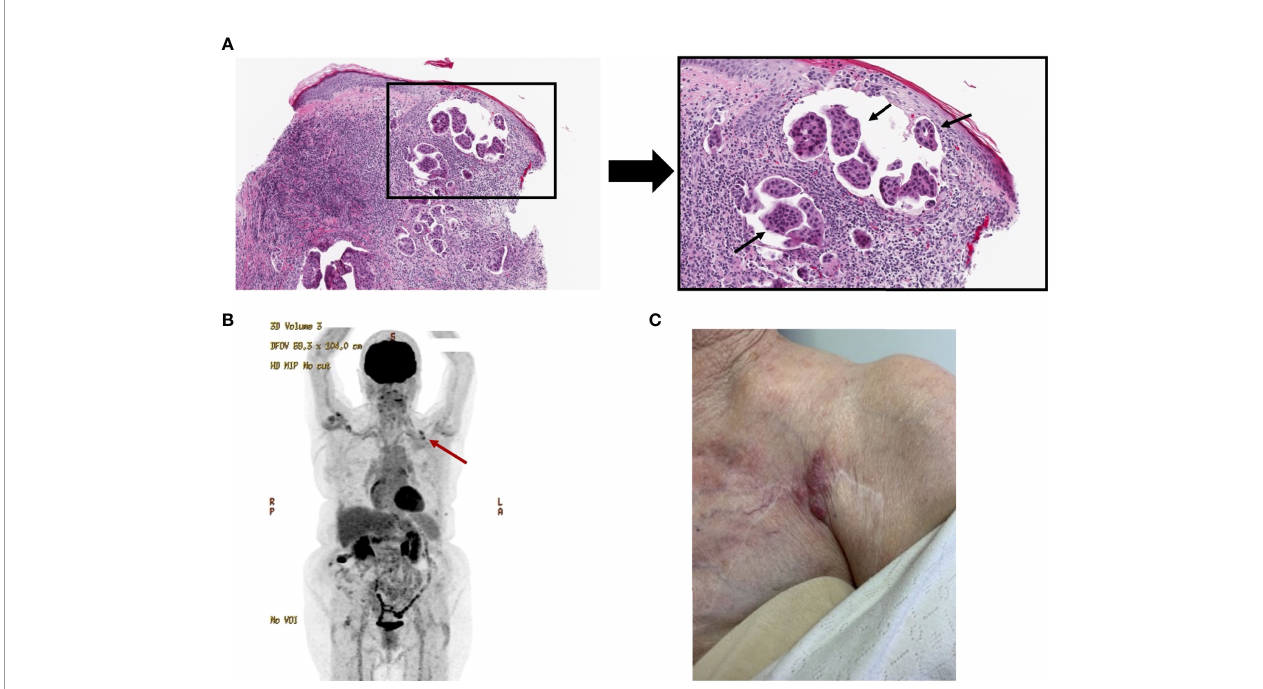
FIGURE 1 | Initial presentation of an 81-year-old female with cutaneous breast cancer metastasis. (A) Histological H&E-stained image of cutaneous breast cancer metastasis, under 100X magni fi cation (left) and higher power view, 200X magni fi cation (right) of the metastatic adenocarcinoma, highlighted with arrows. This biopsy was obtained approximately at the fi rst treatment timepoint. (B) PET-CT, obtained at the fi rst treatment timepoint, revealing PET-avid uptake overlying the left pectoral muscle, highlighted with red arrow. (C) Image of the lesion